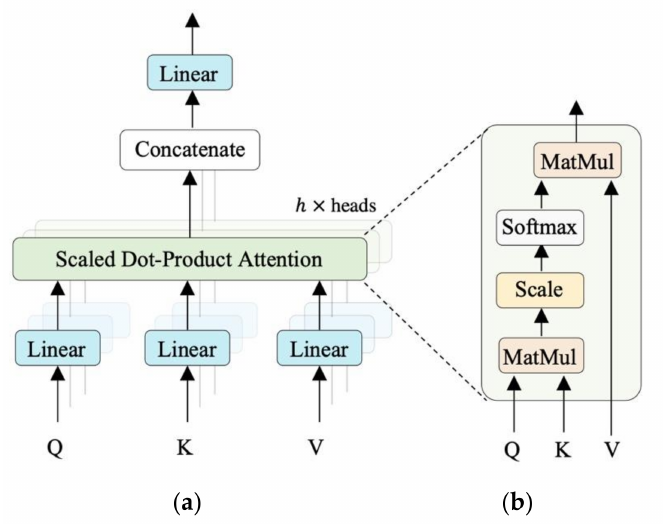
Figure 2. Attention architecture. ( a ) Multi-head self-attention and ( b ) Scaled dot-product